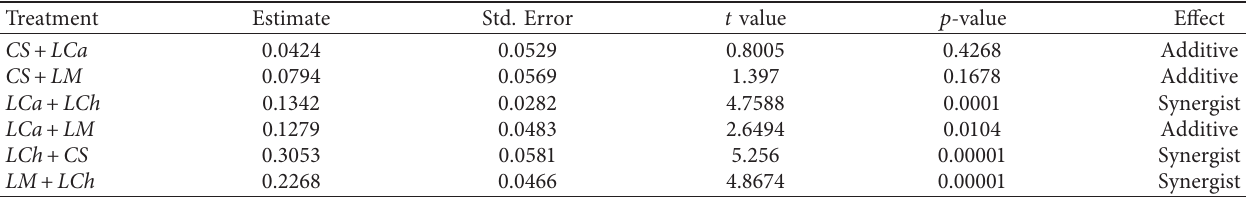
Table 6: ANOVA contrasts comparing the response of Culex quinquefasciatus larvae to EO combinations relative to individual oils. Treatment Estimate Std.